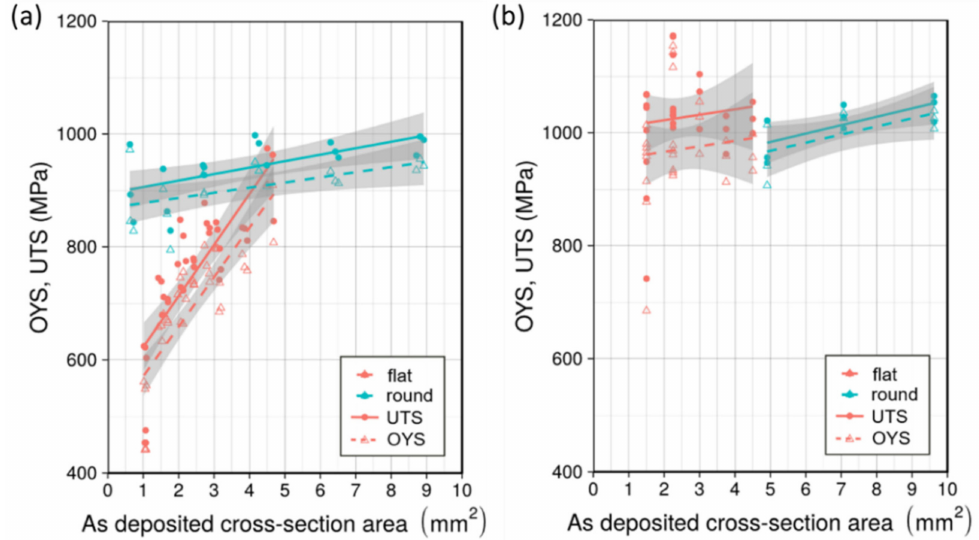
Figure 6. Average value of OYS and UTS with standard deviation for: ( a ) as-deposited EBM-processed flat and round specimens; ( b ) machined EBM-processed flat and round specimens.